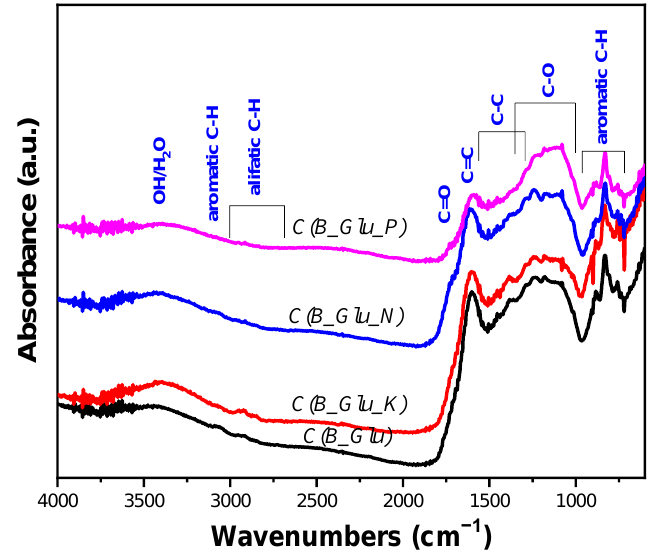
Figure 10. DRIFTS spectra of obtained carbons.